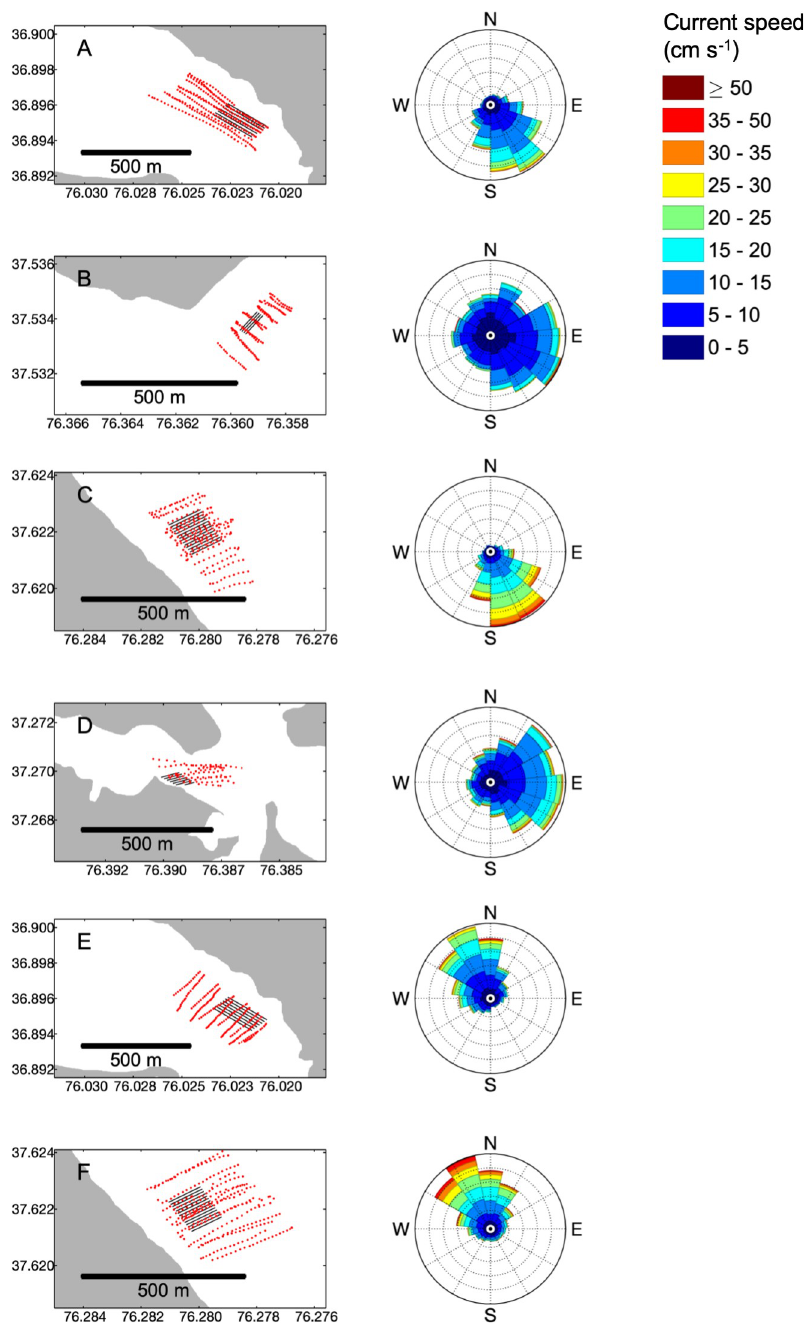
Fig 2. Spatial resolution of sampling and current direction on each sampling cruise. For sampling cruises at (A) Broad Bay in summer, (B) Bland Point in summer, (C) Windmill Point in summer, (D) Monday Creek in summer, (E) Broad Bay in fall, and (F) Windmill Point in fall, red circles indicate locations sampled using moving-vessel transects with every nth point shown to represent the subsampling interval for chlorophyll on each cruise, where n = 4 to 14 depending on the cruise (Table 2). Black lines indicate spatial extent and orientation of the cages at each site but do not correspond directly to rows in the array of cages at each site. Righthand panels depict polar histograms of current directions measured during each sampling cruise, with distance from the center indicating relative frequency and color indicating the proportion of each directional observation that fell within the given speeds (cm s -1 ).